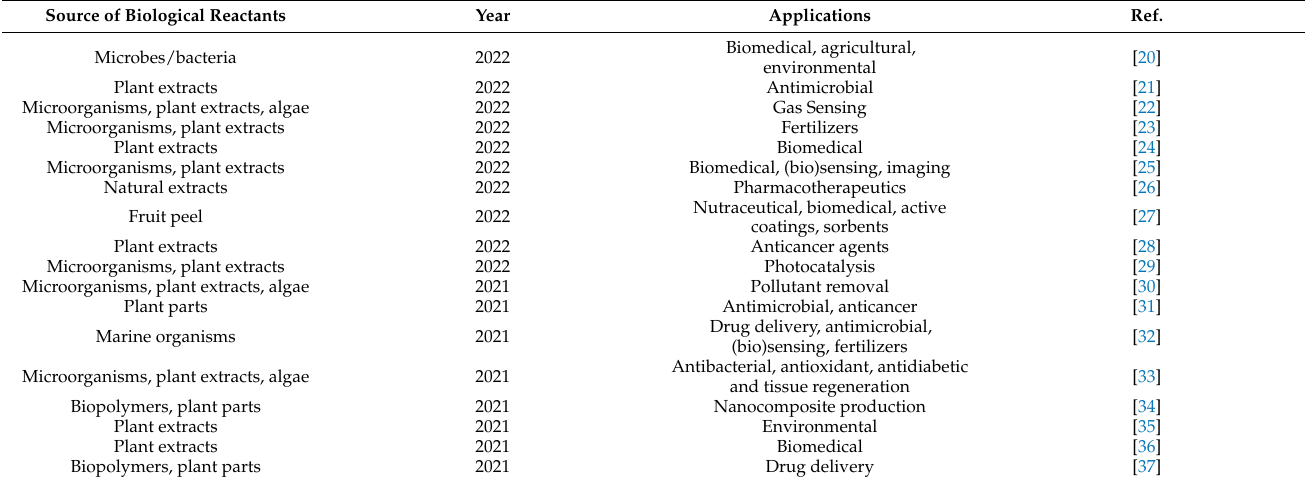
Table 1. Main reviews on biogenic synthesis of ZnONPs published in 2021–2022.